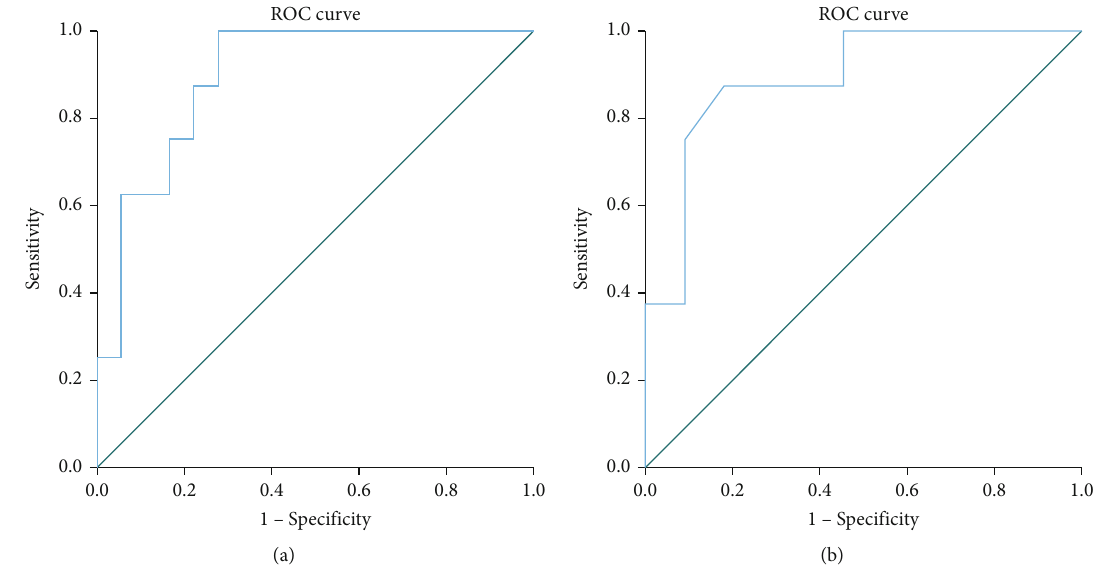
Figure 1: Receiver operating characteristics (ROC) plots illustrating the area under the curve (AUC) model for the prediction of MAS de fi ned by the 2016 MAS classi fi cation criteria. (a) Ferritin/ESR ratio N = 26 , AUC = 0 : 896 (95% CI: 0.78-1.00), p = 0 : 002 . (b) MS score N = 19 , AUC = 0 : 892 (95% CI: 0.74-1.00), p = 0 : 004